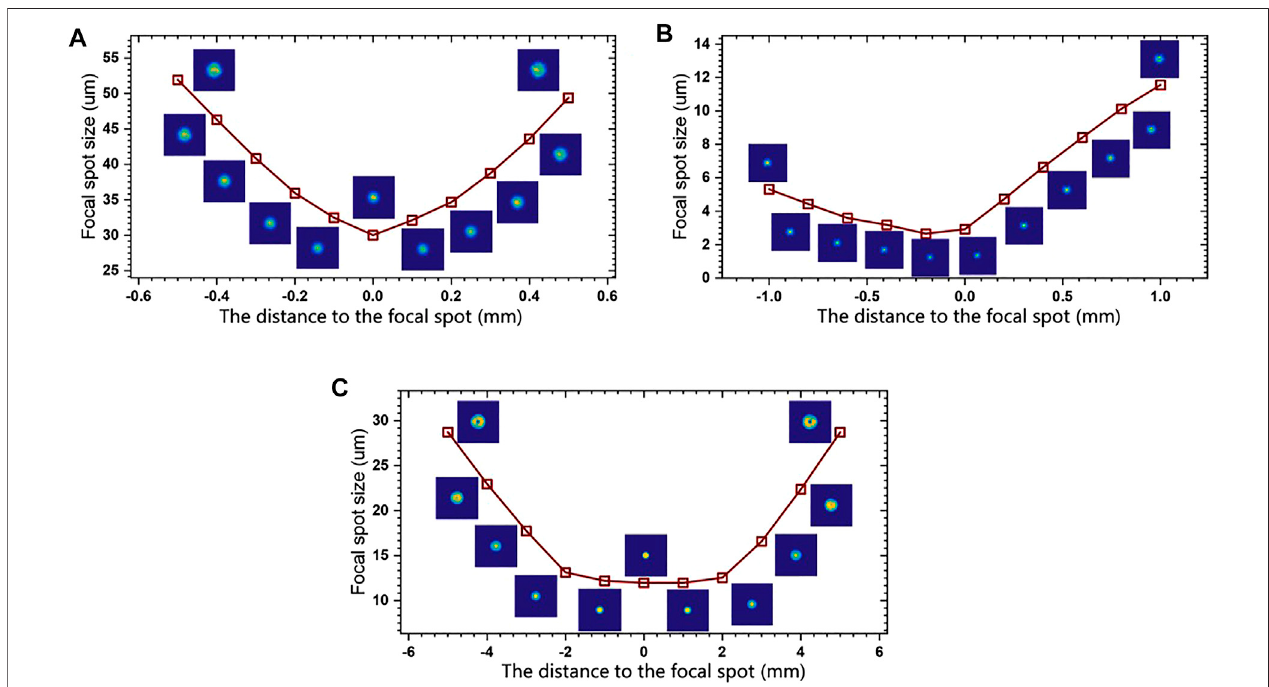
FIGURE 8 | Evolution of the focal spot size with the distance to the focal spot. (A) and (C) are the ellipsoid capillaries El 1 and El 2 , respectively. (B) is the parabolic capillary Pa 1 .